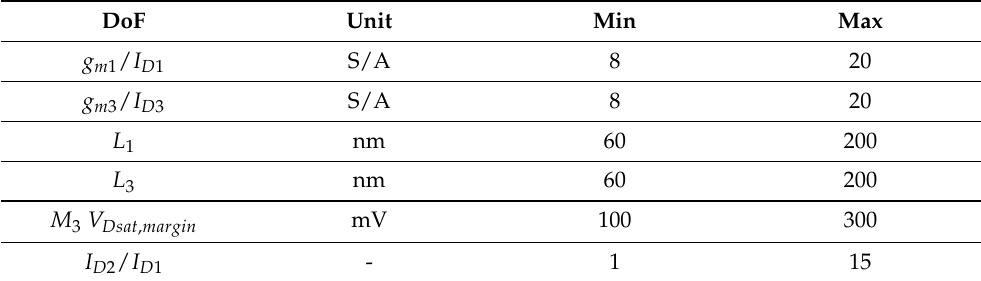
Table 1. DoFs used in the design database